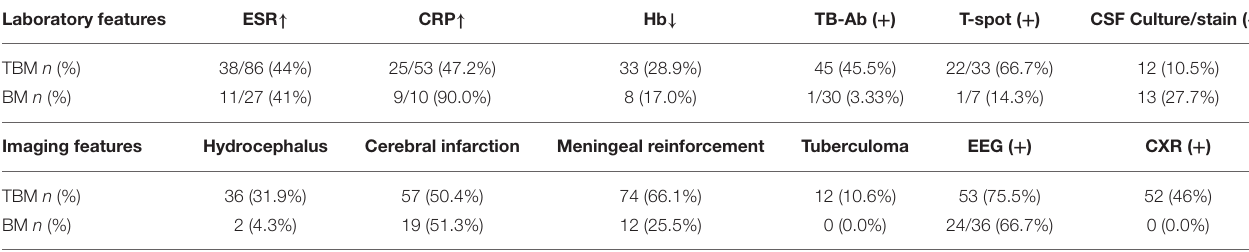
TABLE 1 | Laboratory and imaging features in patients of tuberculous meningitis (TBM) and bacterial meningitis (BM). Laboratory features